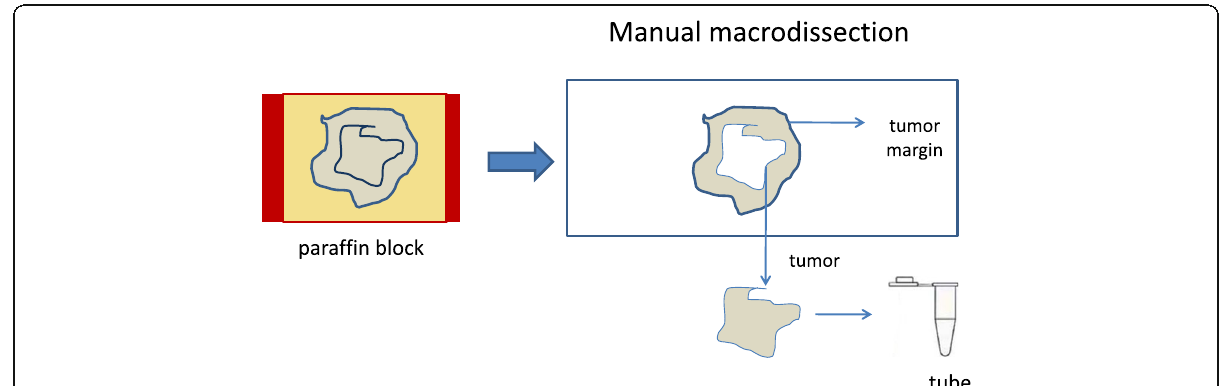
Fig. 1 Study workflow. Study procedure was divided to two analyses: Analysis of mutations for GIST diagnosis by Sanger sequencing and STR analysis for detection of molecular